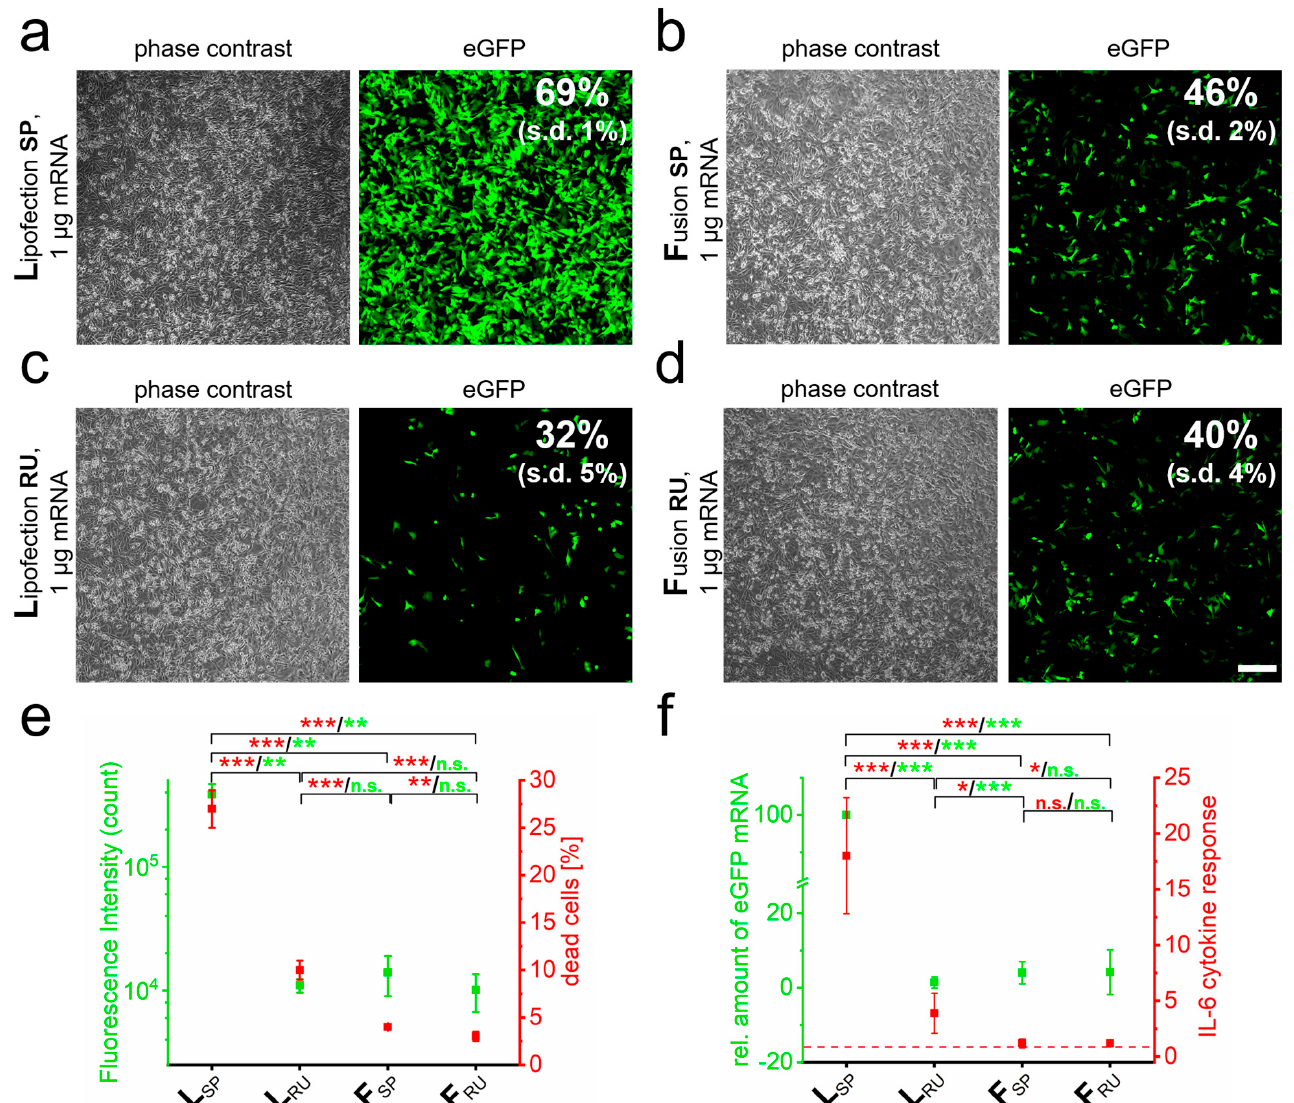
Figure 1. RNA quantity and transfer method influence biocompatibility and immune response. eGFP-mRNA was transferred into PC-12 cells by lipofection ( L ) ( a ) and fusion ( F ) ( b ) based standard protocols ( SP ) and analyzed 24 h after transfer by phase contrast and fluorescence microscopy. Transfection efficiency was determined by flow cytometry. Identical analyses with reduced uptake ( RU ) conditions were performed for lipofection ( c ) and fusion ( d ). Analyses of cells as indicated in a to d for cell death and fluorescence intensity are shown in ( e ). Cells were additionally harvested for mRNA isolation and characterized for IL-6 and eGFP by qRT-PCR ( f ). eGFP-mRNA was used in a concentration of 4 µ g/mL for fusion and 2 µ g/mL for lipofection. In all cases, a total of 1 µ g was transferred per substrate. n = At least three independent experiments were used for each analysis. p -values: not significant (n.s.): p > 0.05, *: p ≤ 0.05, **: p ≤ 0.01, ***: p ≤